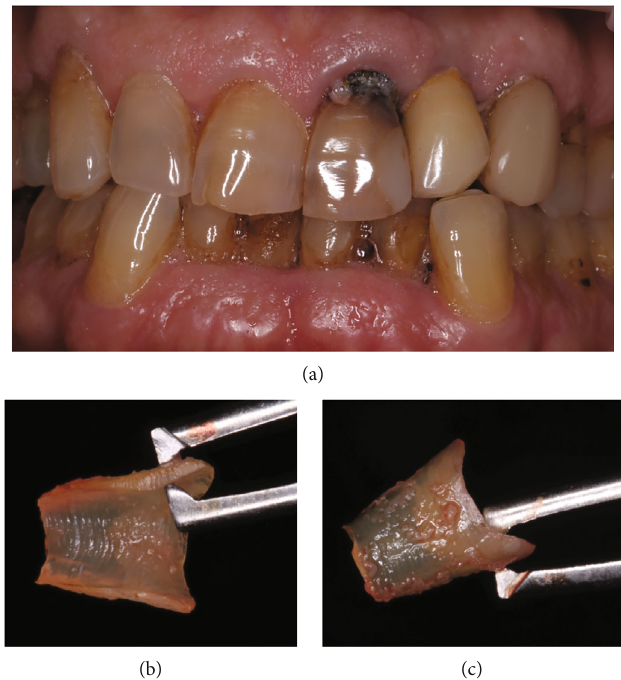
Figure 1: (a) Clinical aspect of the central left incisor with a great decay on the cementoenamel junction. (b and c) Portion of the root after being shaped extraorally. The periodontal ligament fi bers on the root remain untouched and visible on the buccal